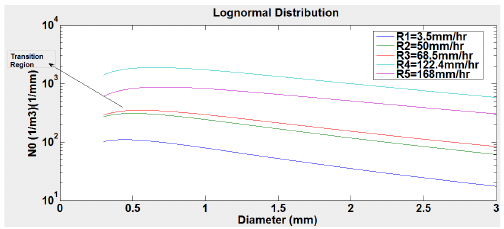
Fig. 4. Lognormal curves for different rainfall intensities obtained from NLC data.